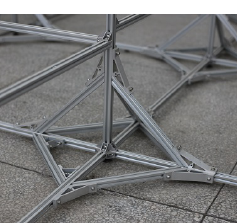
First image. Second image. Third image. Figure 5. Images of the second